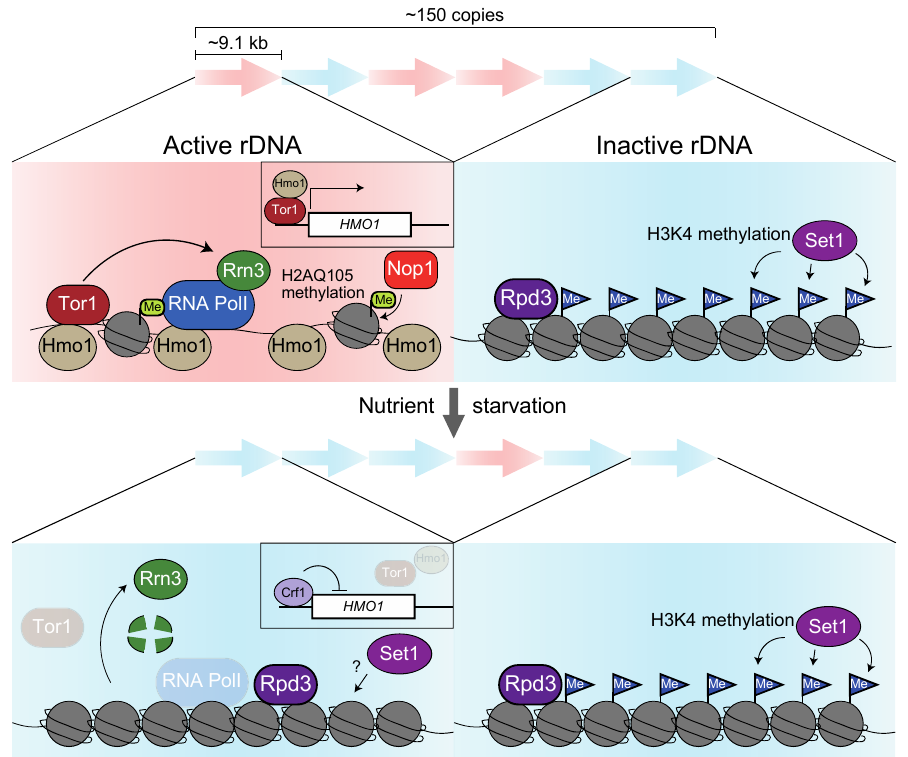
Figure 3. Regulatory mechanisms of rRNA expression in S. cerevisiae . A graphical view of how rDNA genes are transcriptionally regulated before and after starvation. In S. cerevisiae , half of the 150 copies of rDNA genes are active (the pink area). In contrast, nutrient starvation inactivates many repeats by the degradation of Rrn3, dissociation of Hmo1, and loss of H2AQ105 methylation (the blue area). Upon starvation, TORC1 deprivation leads to the accumulation of repressor Crf1 at the HMO1 promoter, resulting in the downregulation of HMO1 expression (in black square boxes). The deacetylase Rpd3 maintains a closed-chromatin formation, and H3K4 methyltransferase Set1 re- presses rRNA transcription in inactive rDNA repeats.